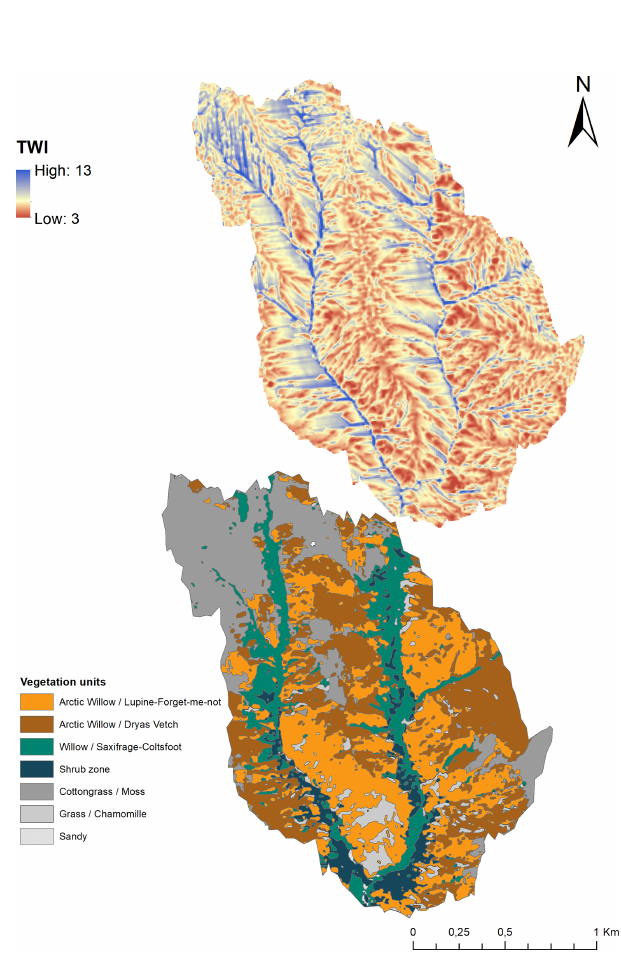
Figure B2. Topographic wetness index (TWI) map compared to vegetation units located on Qikiqtaruk/Herschel